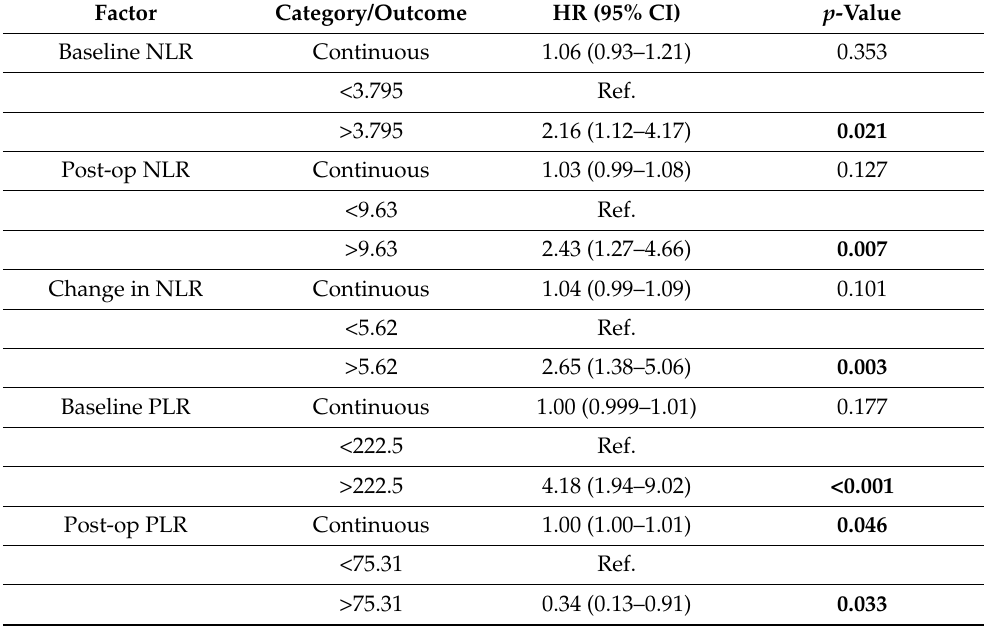
Table 3. Multivariate analysis of NLR and PLR for overall